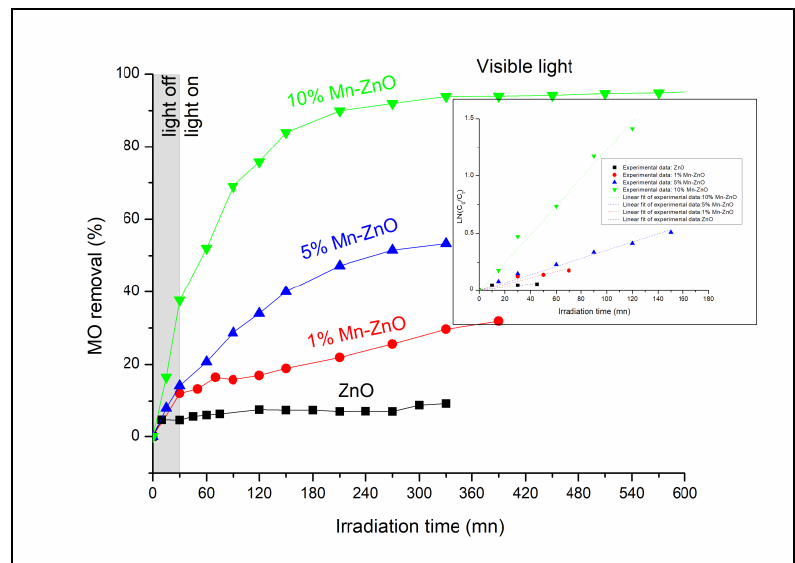
Figure 7. MO conversion as a function of irradiation time under visible light for ZnO and x%Mn-ZnO